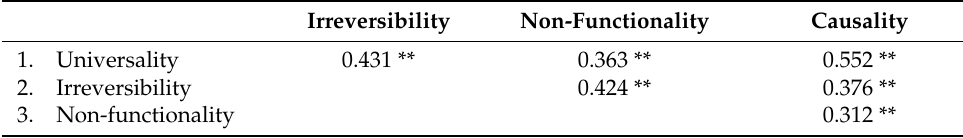
Figure 1. Second-order four factors EsCoMu model. Latent variables are represented by ellipses and measured variables are represented by rectangles. Values are standardized estimated correlations between factors. Table 5. Intercorrelations between EsCoMu